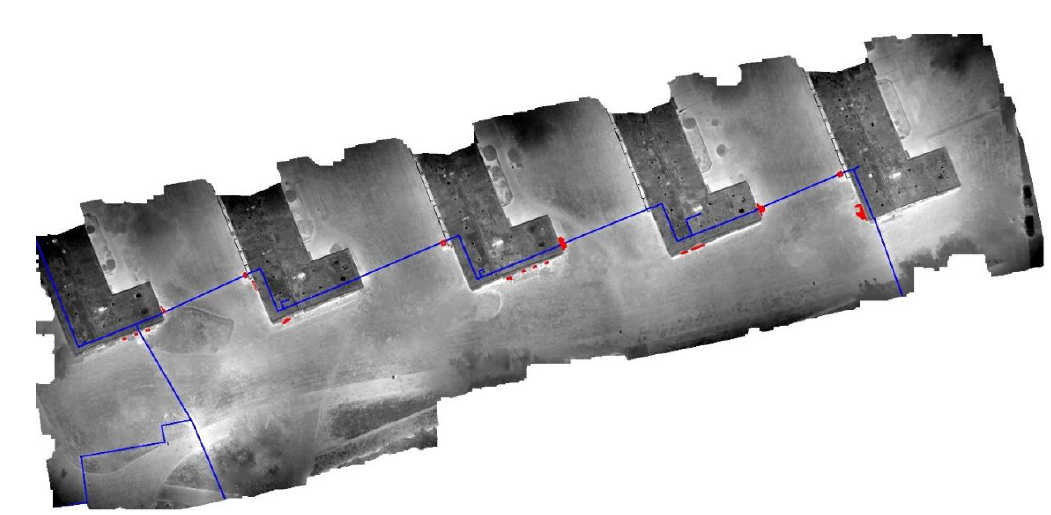
Figure 12 Anomaly detection - flight site